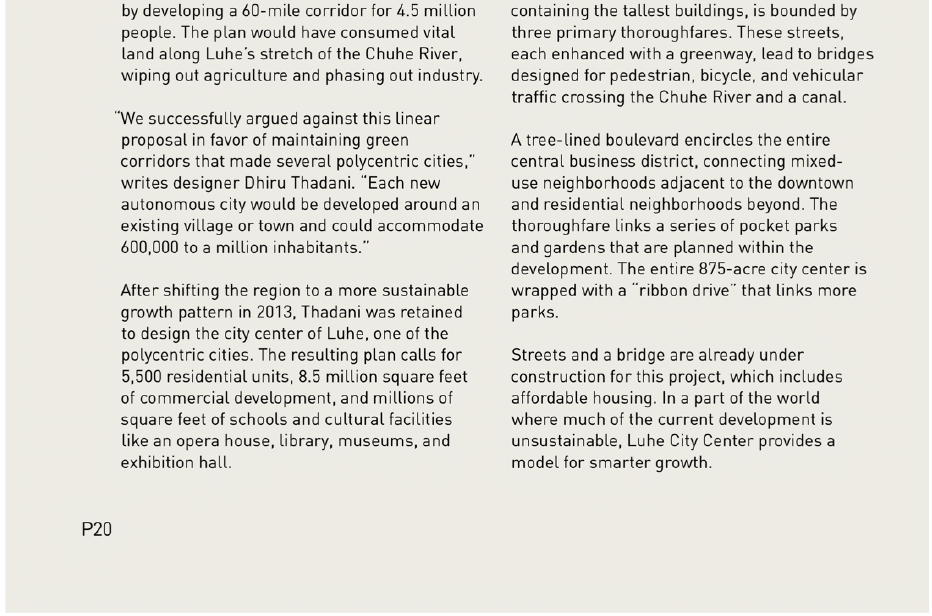
Figure 1. Merit Award Citation for Luhe City Center, from the 2015 Charter Awards. Source: CNU